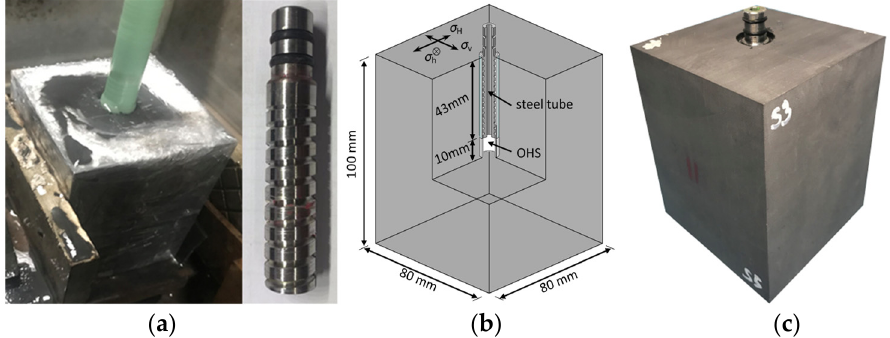
Figure 2. Specimen preparation for hydration and hydraulic fracturing: ( a ) drilling blind hole to simulate the wellbore, the right side is a steel pipe used as a casing; ( b ) schematic diagram of well completion; ( c ) a specimen for hydration and hydraulic fracturing.